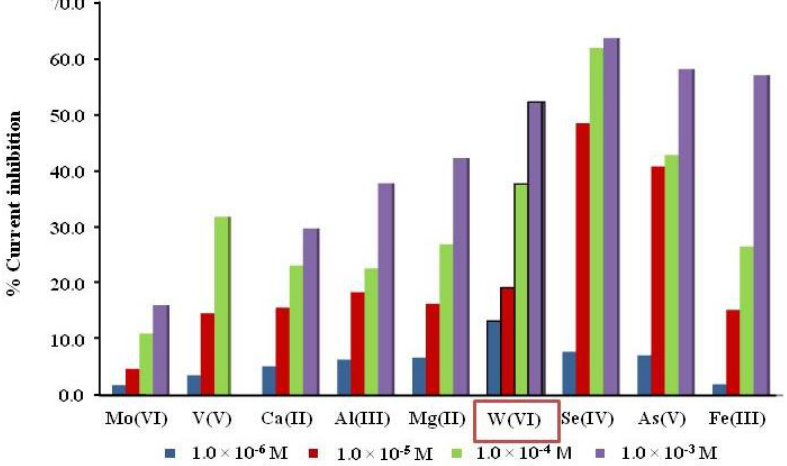
Figure 3. Percentage of inhibition current from several cations at 10 −6 M, for ALP biosensor Tris HCl buffer pH 8.0, 0.36 M KCl; 0.20 V; 0.32 mM; 2-P-L-Asc as a substrate.